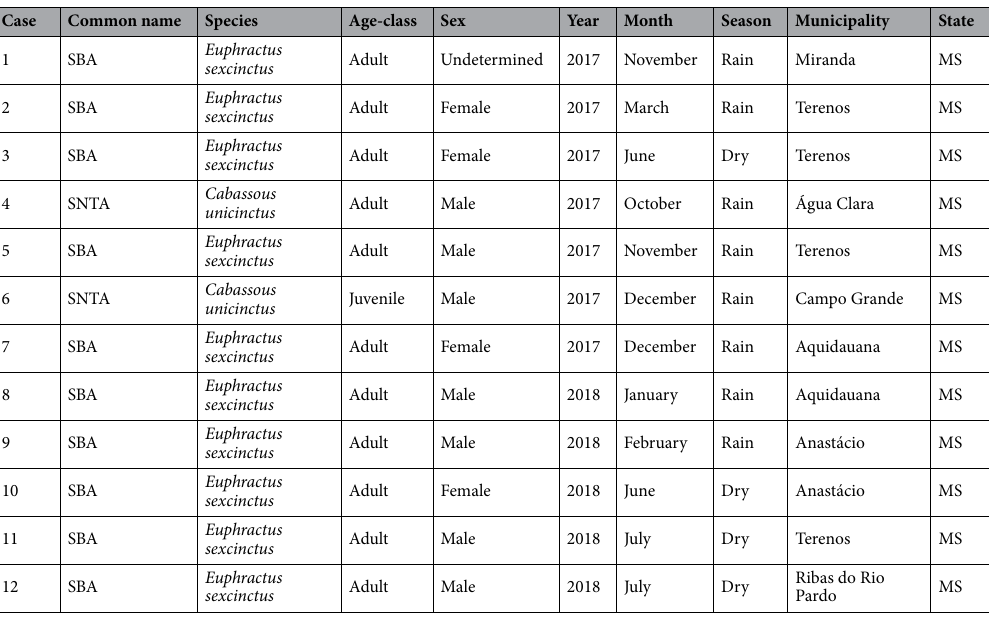
Table 1. Biological and epidemiological data wild armadillos with pulmonary adiaspiromycosis died by motor vehicle collisions in Brazil, 2017–2020. SBA Six-Banded Armadillo, SNTA Southern Naked-Tailed